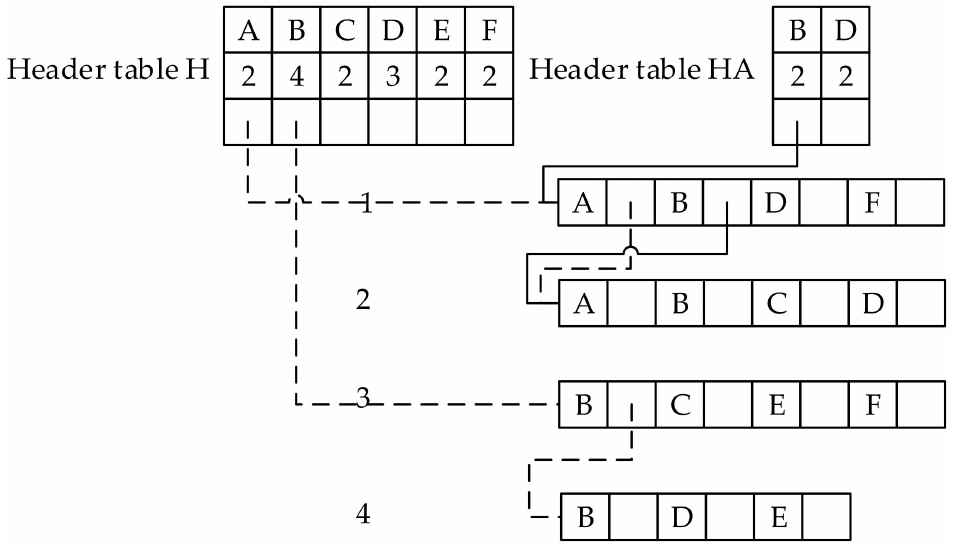
Figure 2. Header table